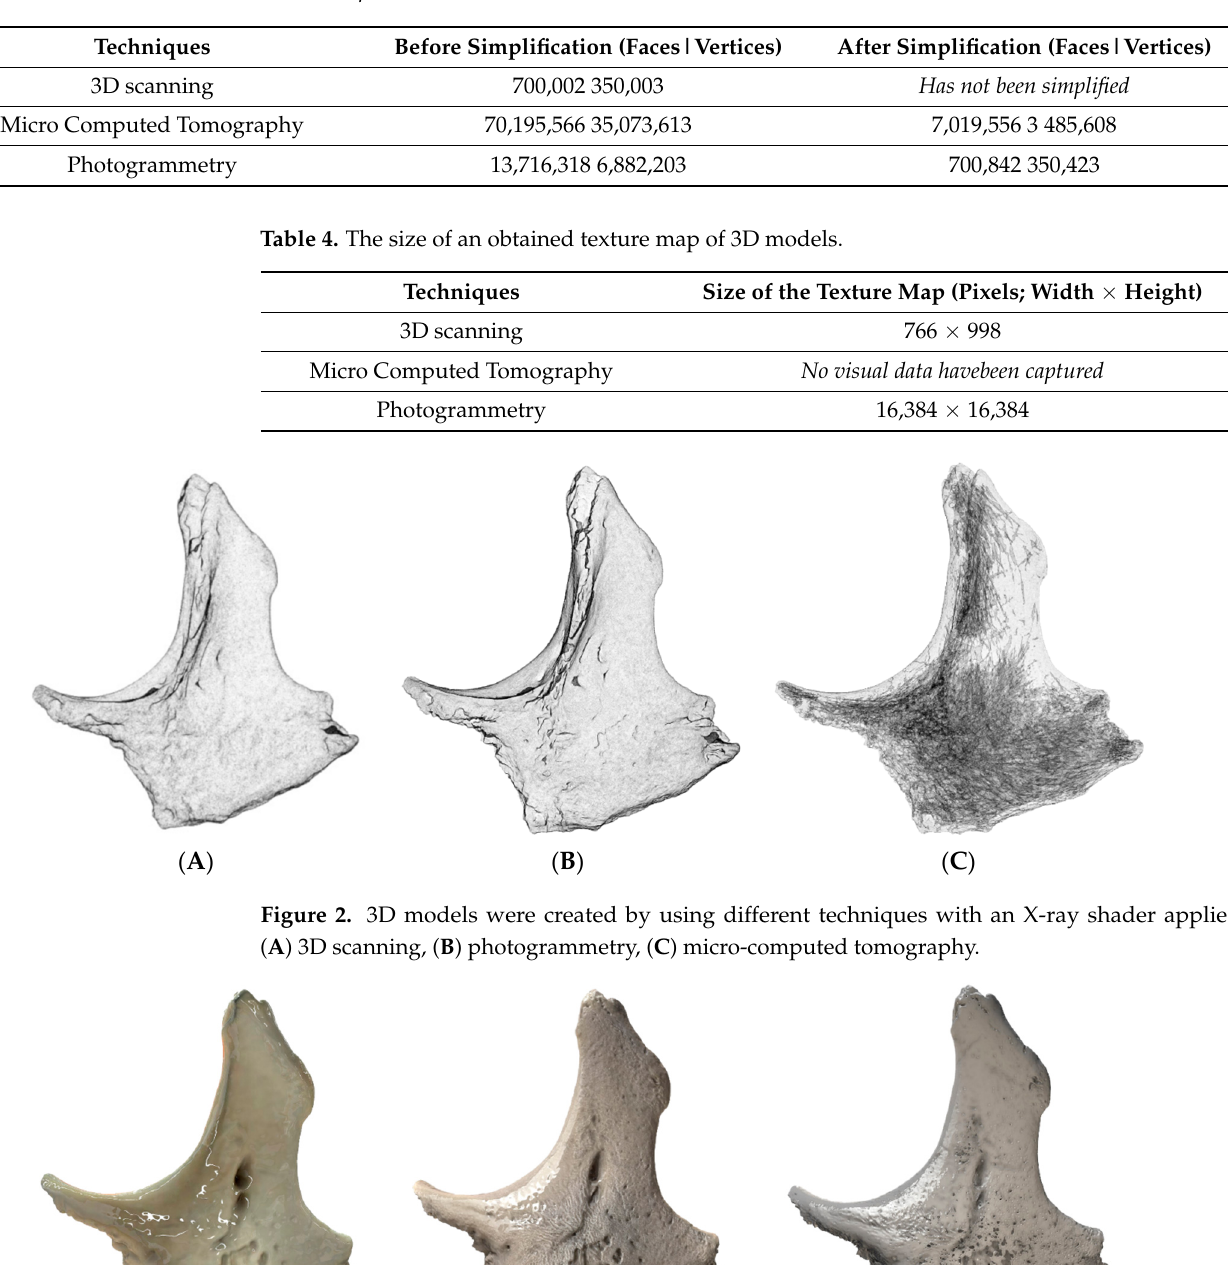
Table 3. The number of faces and vertices of 3D models before and after application of the Simplifi- cation and Optimization Protocol . Table 4. The size of an obtained texture map of 3D models.